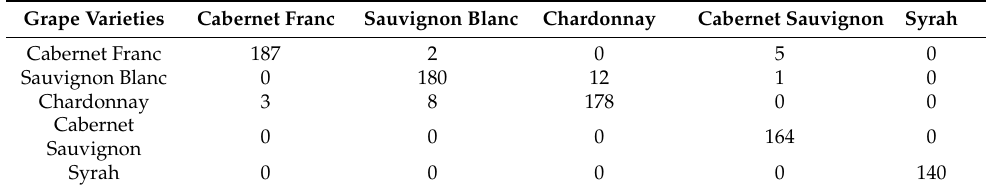
Table 5. The confusion matrix of the 10 independent runs on the test set with fc6 + Fc1000 (ResNet50) fused deep